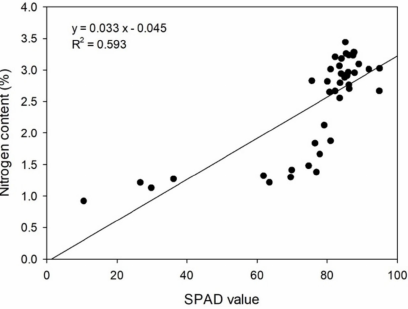
Figure 2. Linear regression of SPAD values and the N content as measured in leaves of